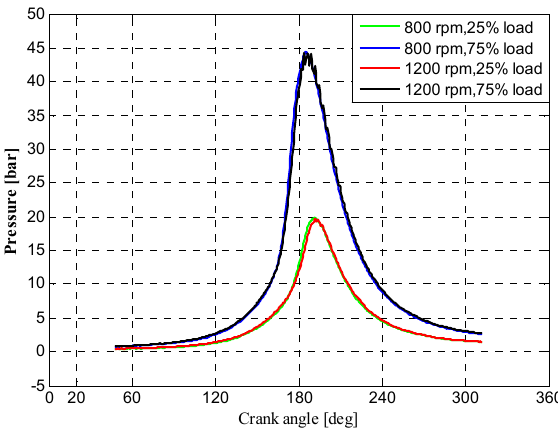
Figure 11. In-cylinder pressure at four working conditions.